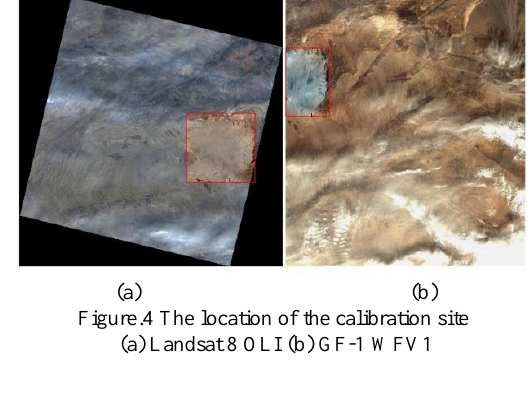
Figure.5 Cumulative frequency of uniformity (a) Landsat 8 OLI (b) GF-1